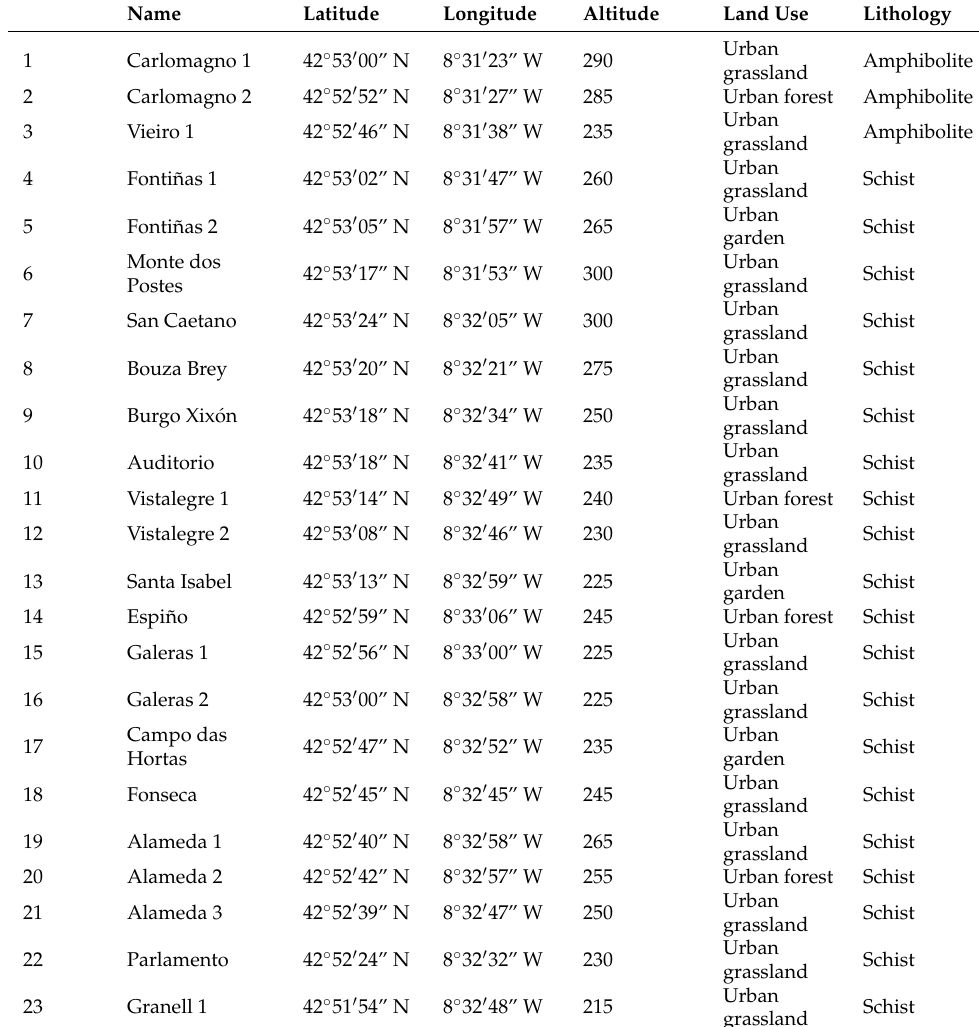
Table 1. List of sampling